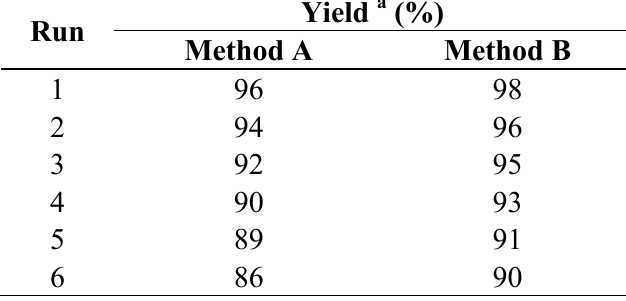
Table 4. Recyclability of nanosilica sulfuric acid prepared of rice